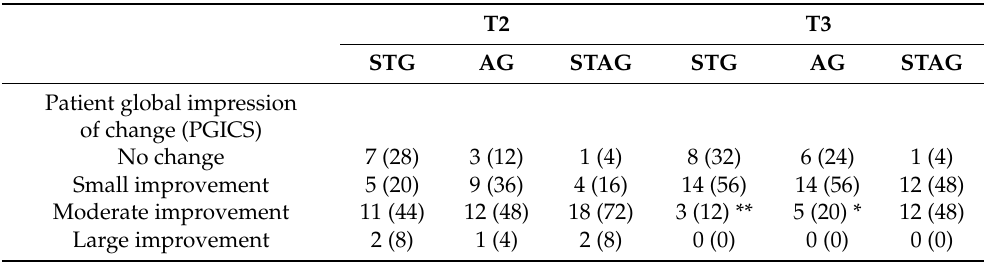
Table 3. Between-group comparisons in post-intervention and follow-up assessments of patient global impression of